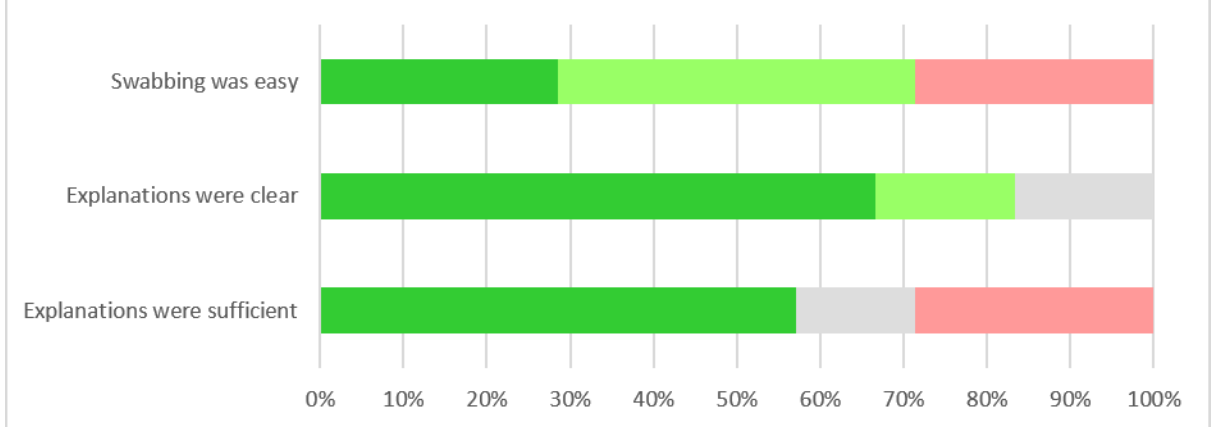
Figure 6. Acceptability of nasopharyngeal swab